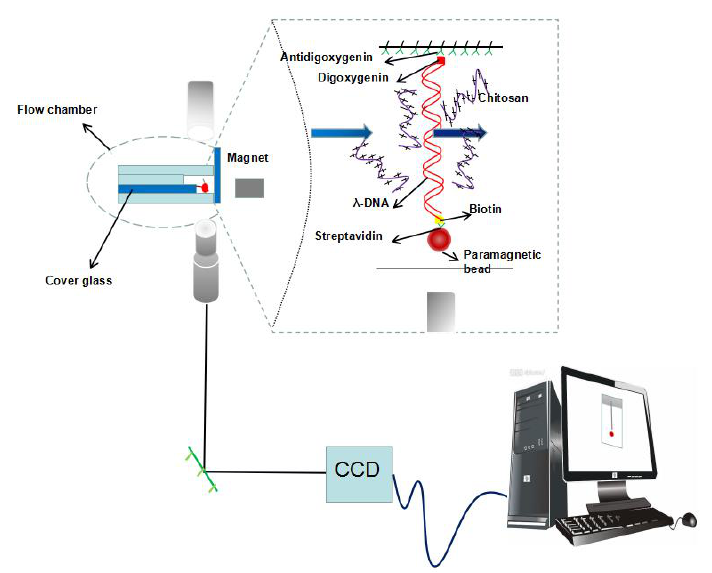
Figure 1. A schematic diagram of magnetic tweezers .